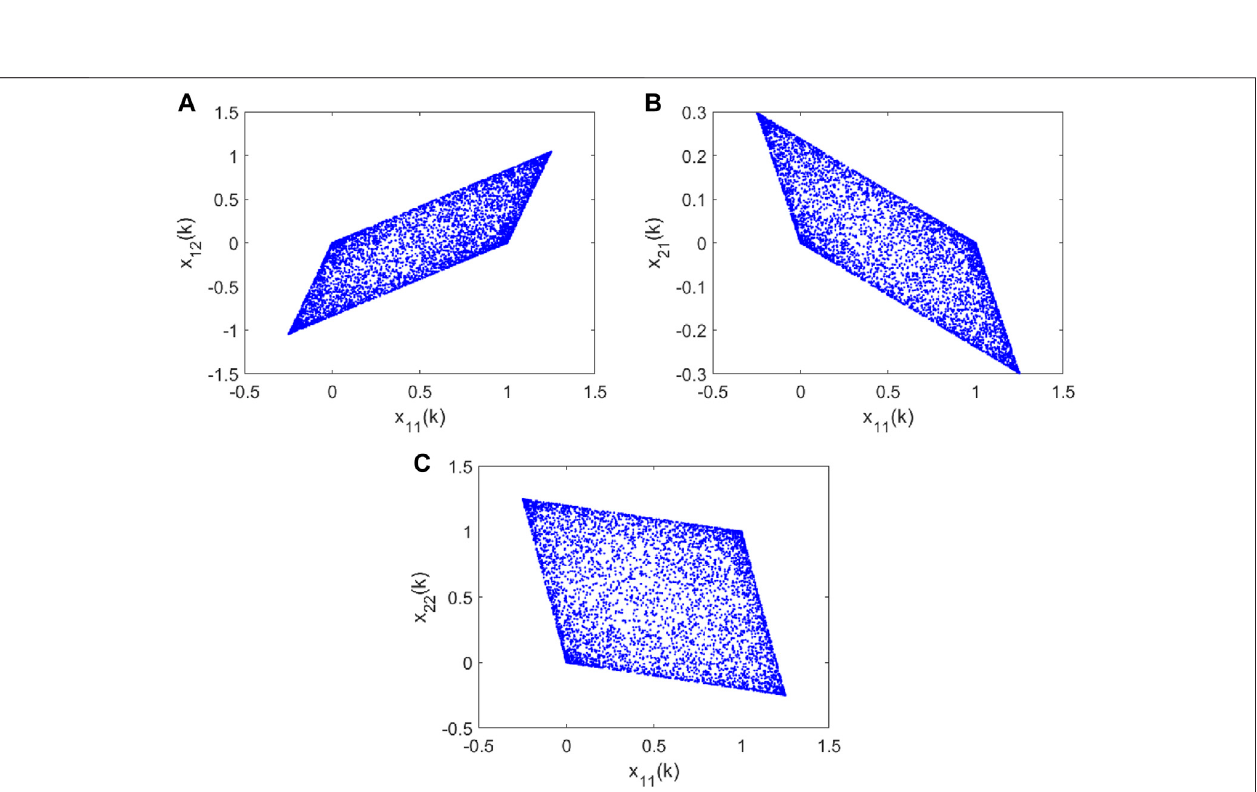
FIGURE 13 | Phase portraits of the multidimensional logistic map with N = 2: (A) x 11 − x 12 , (B) x 11 − x 21 , and (C) x 11 − x 12 .